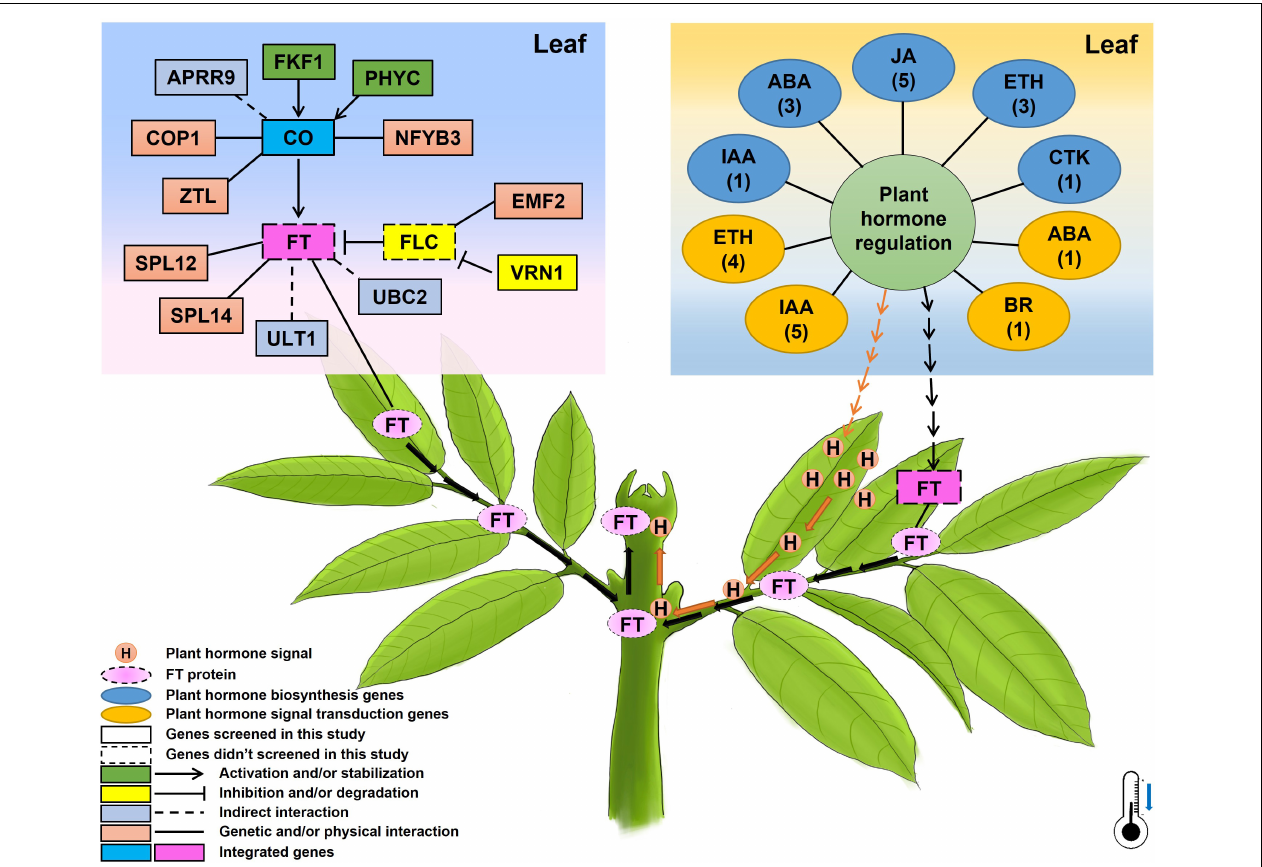
FIGURE 8 | A proposed diagram showing the possible genetic pathways regulating flowering time/floral transition underlying chilling accumulation in litchi. The numbers below the names of plant hormones in the oval boxes represent the members of the identified CAGs, and the thermometer with a blue arrow indicates the low temperature required for litchi flowering in